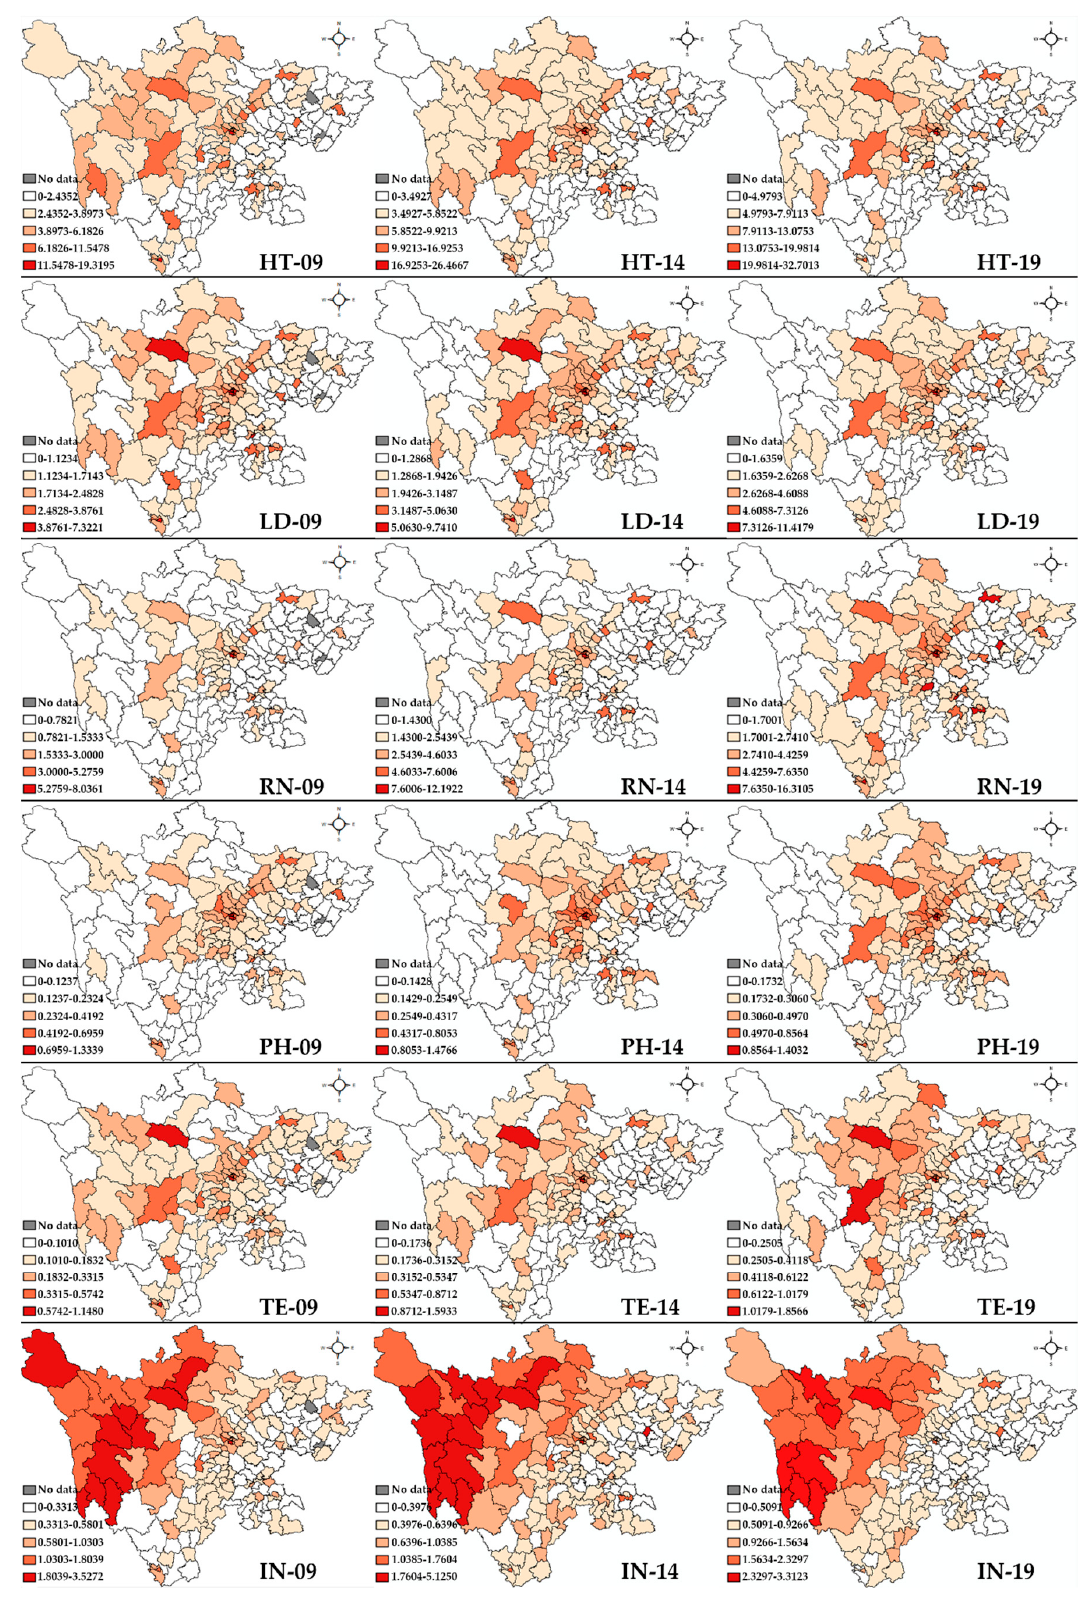
Figure 4. The hierarchy maps of the numbers of all types of healthcare professionals per 1000 people in 2009, 2014, and 2019. HT, health technician; LD, licensed doctor; RN, registered nurse; PH, pharmacist; TE, technologist; IN, intern.